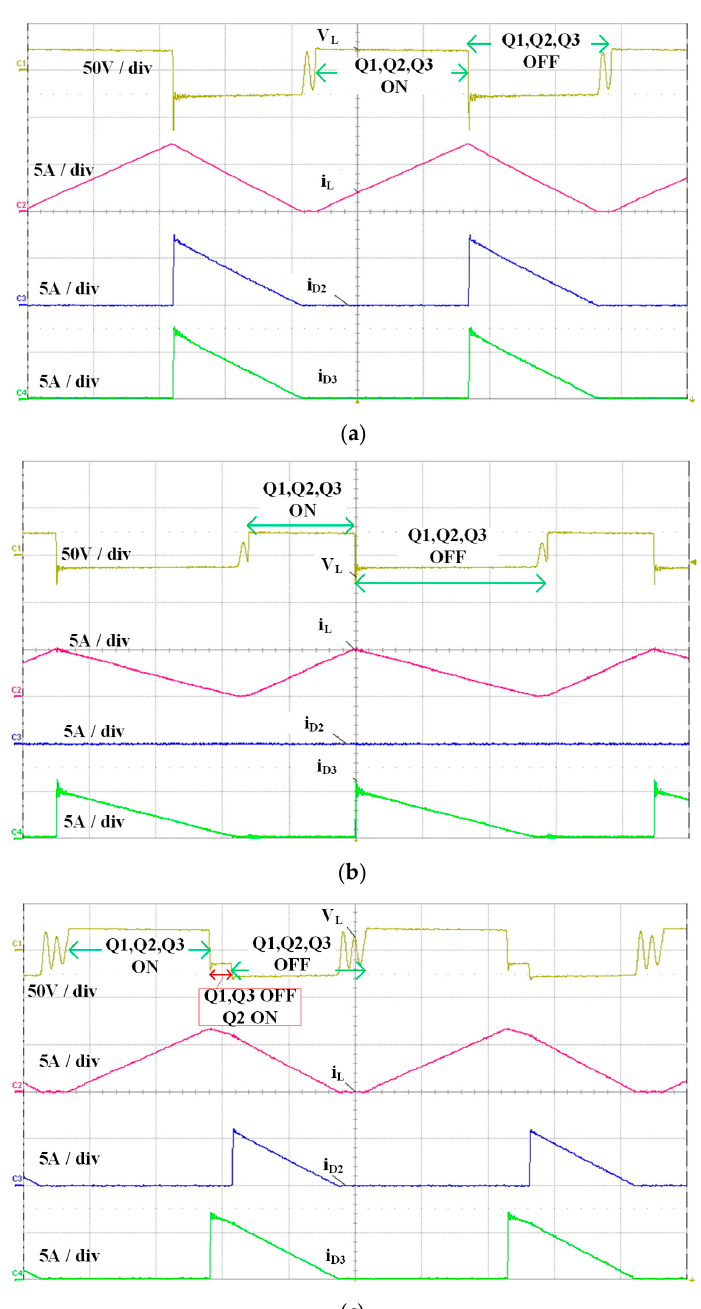
Figure 18. Measured waveforms of step-up/down mode in ( a ) DCC, ( b ) SCC and ( c ) HCCCV regions.